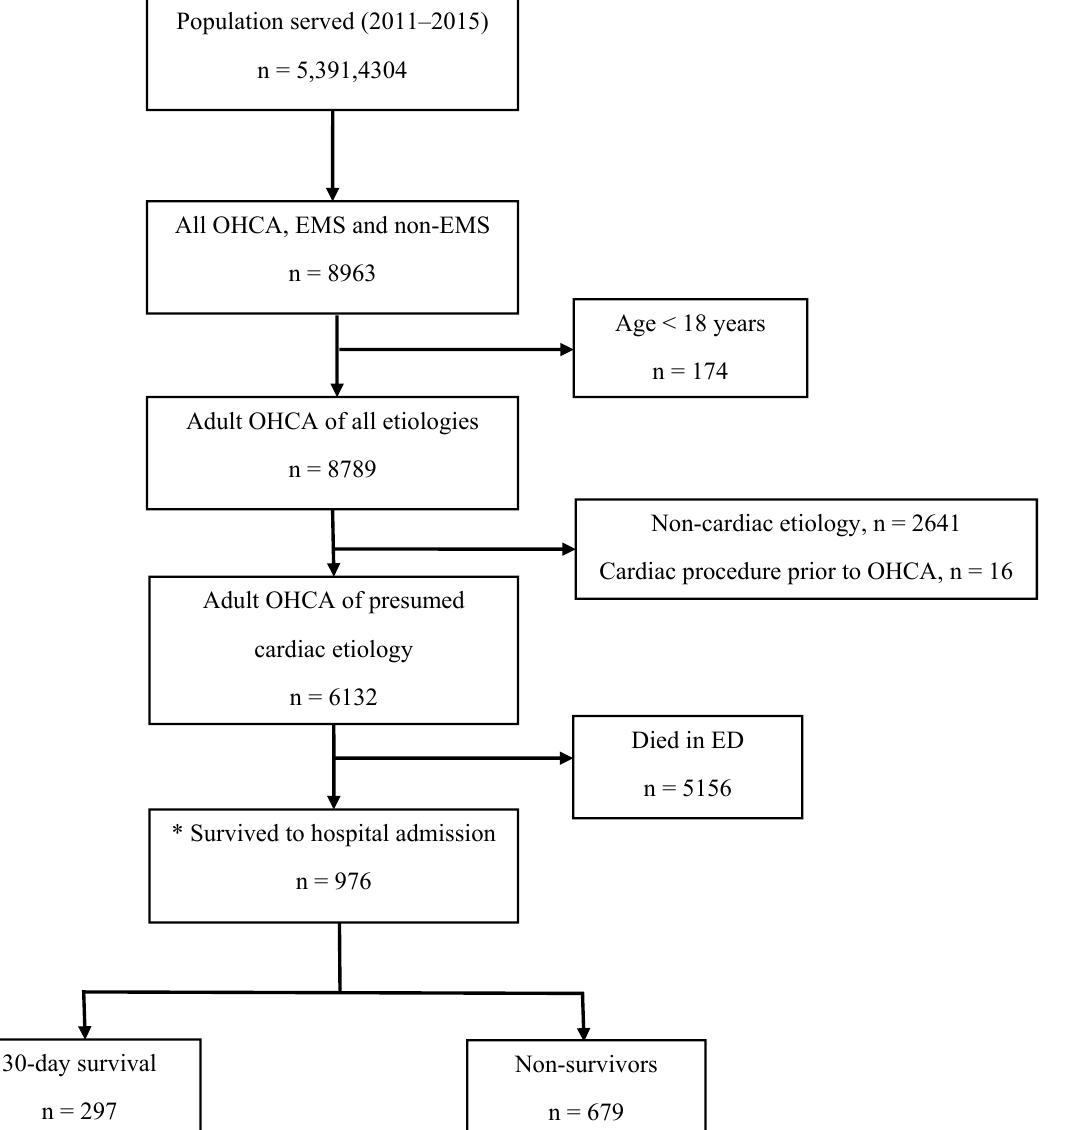
Figure 1. Patient selection. * Refers to the study population. Abbreviations: OHCA, out-of-hospital cardiac arrest; EMS, Emergency Medical Services; ED, Emergency Figure 1 : Patient selection *Refers to the study population